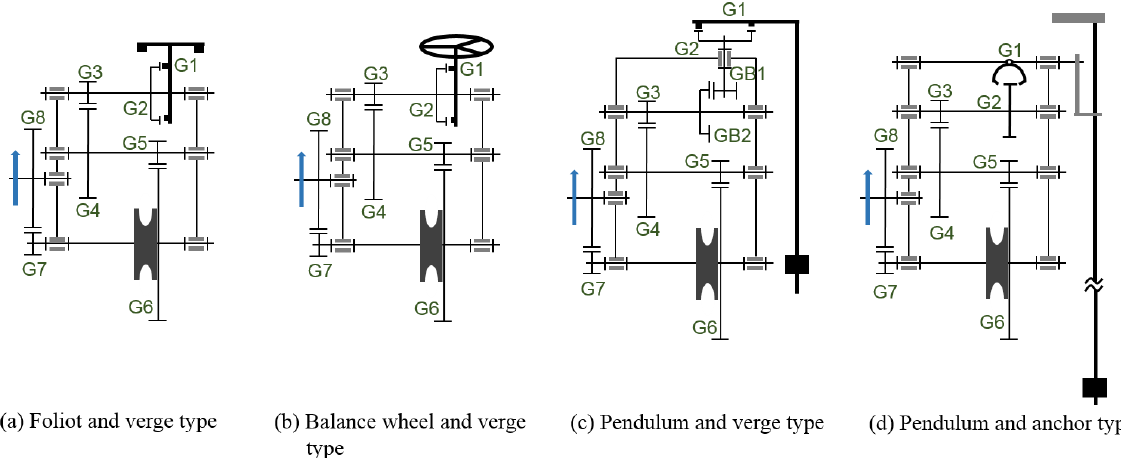
Figure 5. Chamber clocks going-system